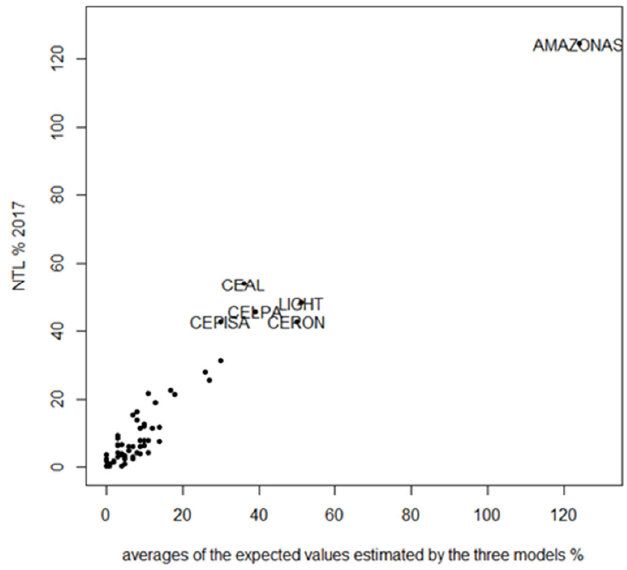
Figure 6. Scatterplot of the averages of the expected values estimated by the three models and the respective verified NTLs.